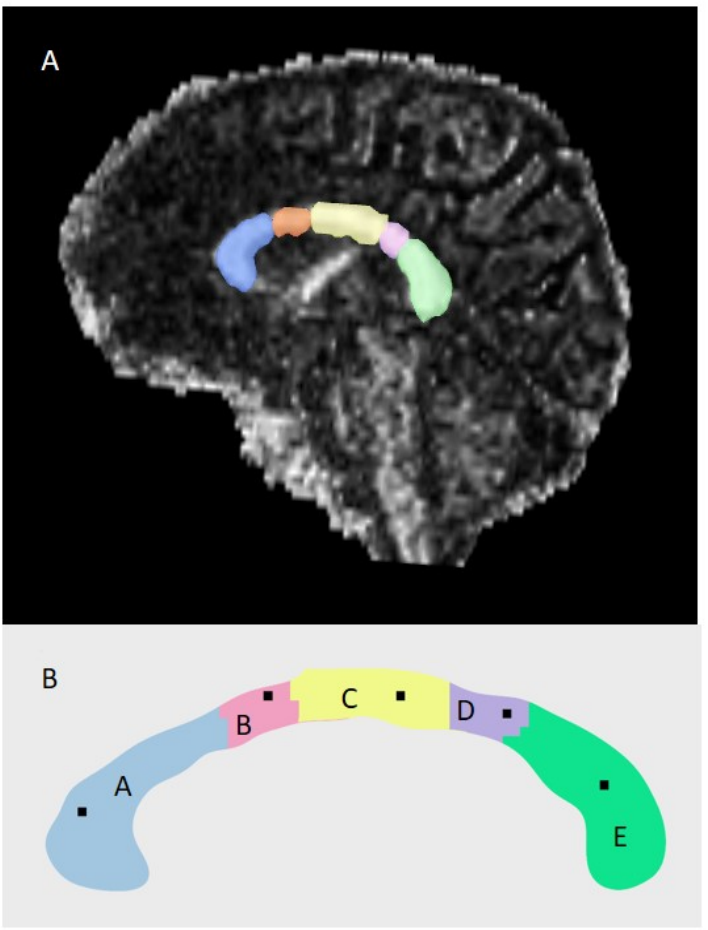
Figure 1. Automatic segmentation of the corpus callosum and parcellation. ( A ) Area of the corpus callosum analyzed in the study. ( B ) Description of the parcels: (A) Rostrum; (B) Genu; (C) Body; (D) Isthmus; (E) Splenium.